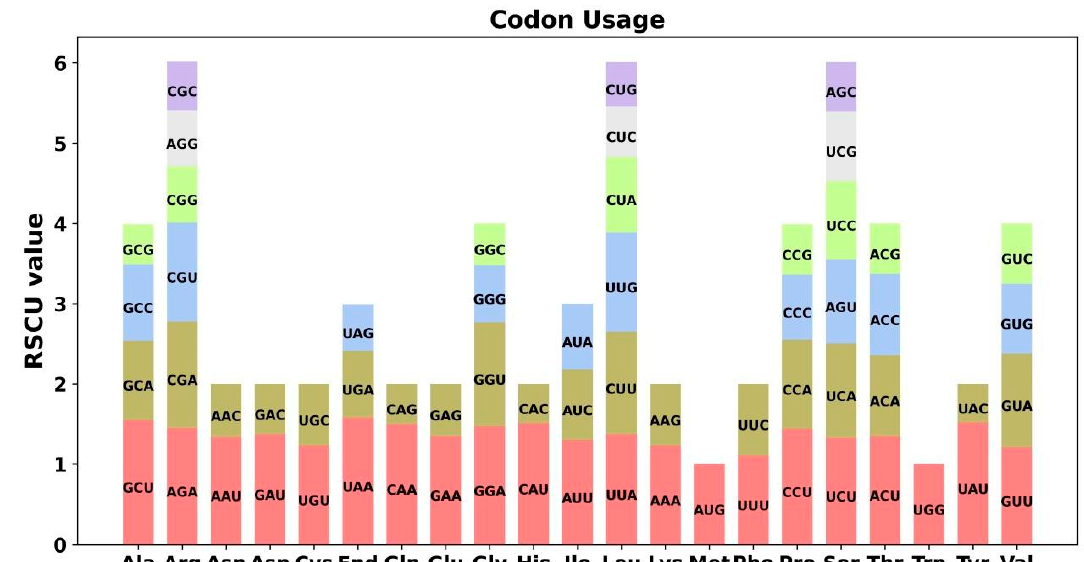
Figure 2. The codon preference analysis of the mitochondrial genome. The rectangles of different colors represent the RSCU values of different codons encoding the same amino acid.